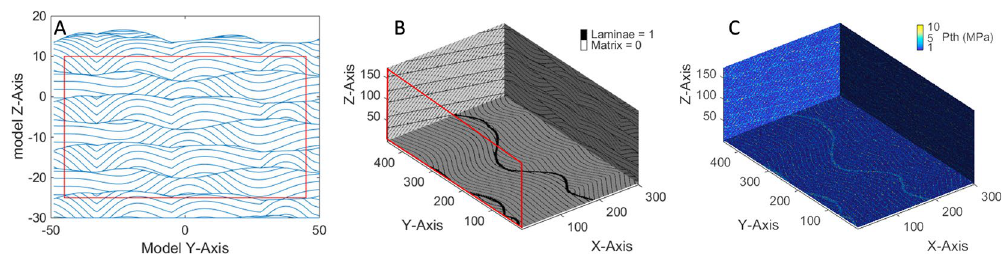
Figure 4. ( A ) Vertical cross section of BAM #36 (see Fig. 1) in the Y-Z plane. The red box represents model subset that is extracted from each vertical slice to build the continuous 3D volume. Horizontal and vertical scale values have no prescribed units, but are reasonably considered to be cm (see text). ( B ) Fence diagram of output binary model showing same architecture of matrix and laminae as in the original Rubin and Carter 26 graphic output. Red polygon same as in ( A ). Axis units are arbitrary, and differ from ( A ) as a result of the gridding process. ( C ) Sample realization of threshold capillary pressure ( P th ) values from same model as ( B ) assuming the matrix is moderately sorted upper coarse sand (MUCSa), and the laminae are composed of moderately sorted upper fine sand